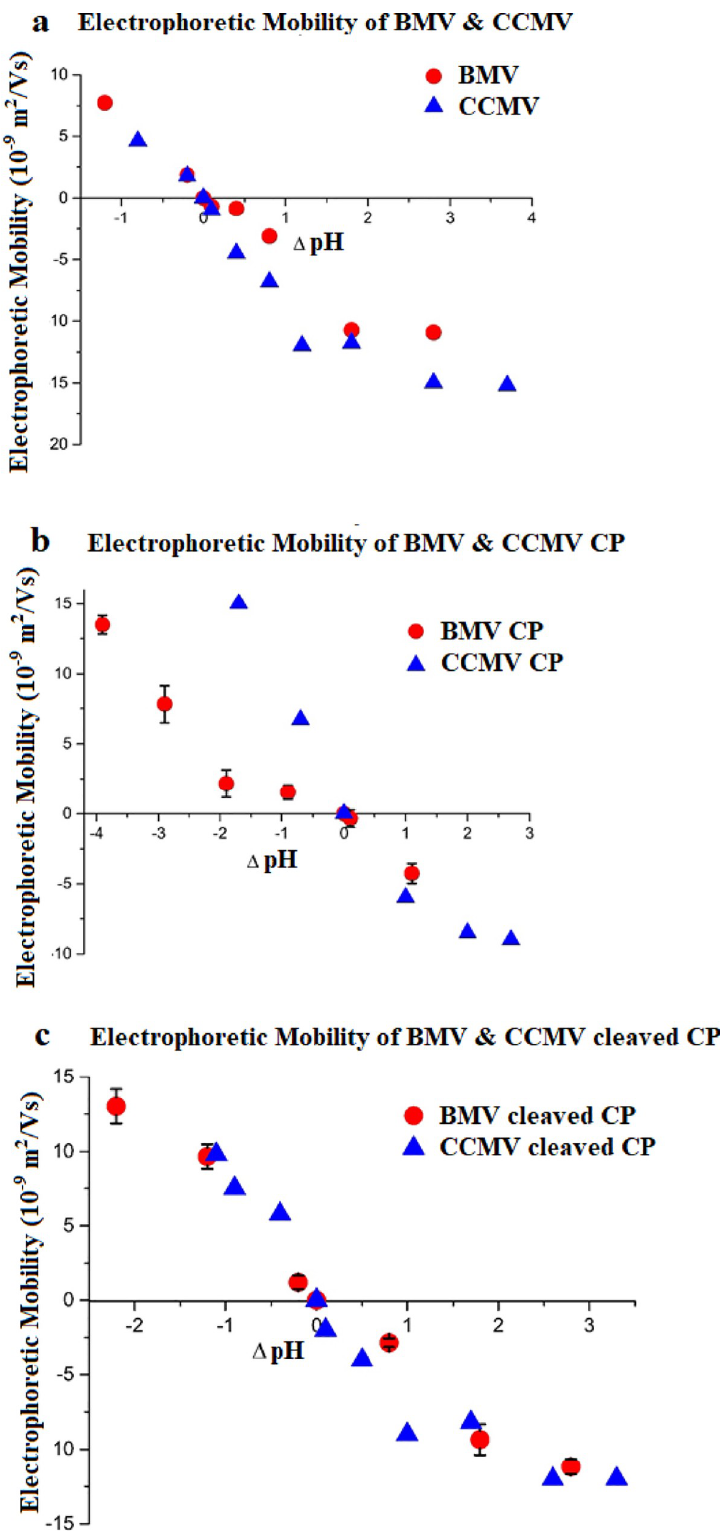
Fig 4. Electrophoretic mobility of the viruses, CPs and cleaved CPs at ionic strengths of 0.02 M, with the ordinate in each case shifted by the appropriate pI, i.e., Δ pH = pH–pI, as a function of pH and ionic strength, for: (a) BMV and CCMV; (b) BMV and CCMV CP; and (c) Cleaved BMV and CCMV CP. https://doi.org/10.1371/journal.pone.0255820.g004 PLOS ONE | https://doi.org/10.1371/journal.pone.0255820 September 10,